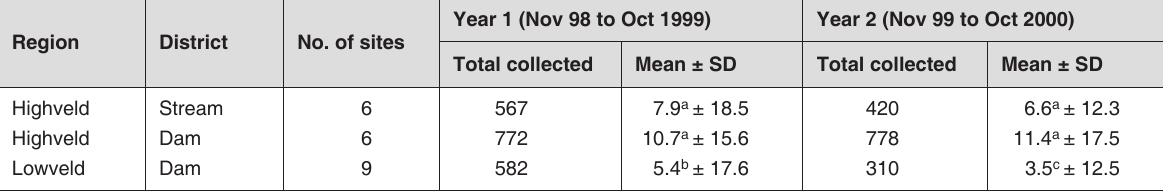
TABLE 7 Seasonal distribution of Lymnaea natalensis in the highveld and lowveld communal grazing areas of Zimbabwe for the peri- od November 1998 to October 2000